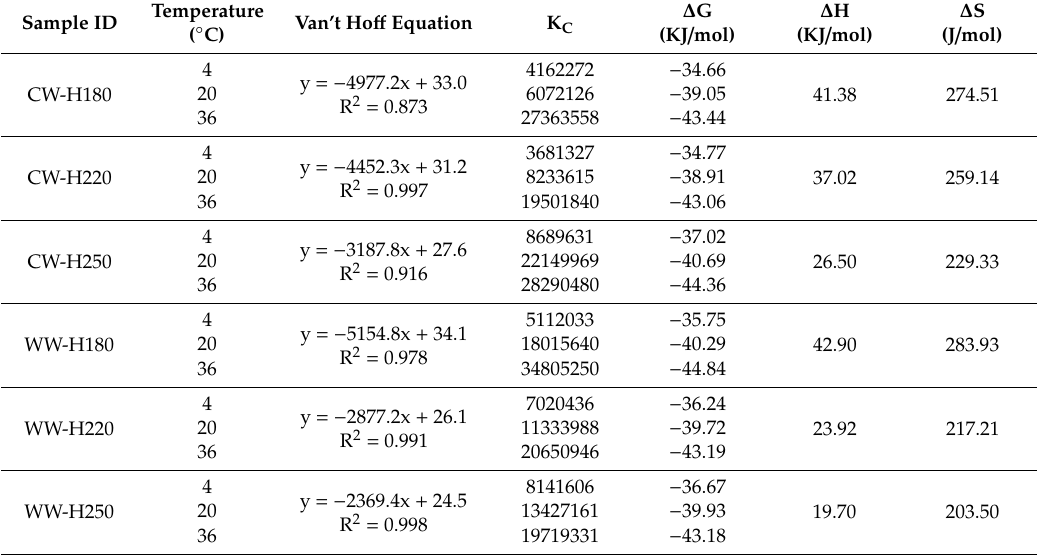
Table 5. Thermodynamic parameters for a dye adsorption process by hydrochars produced from citrus and winery